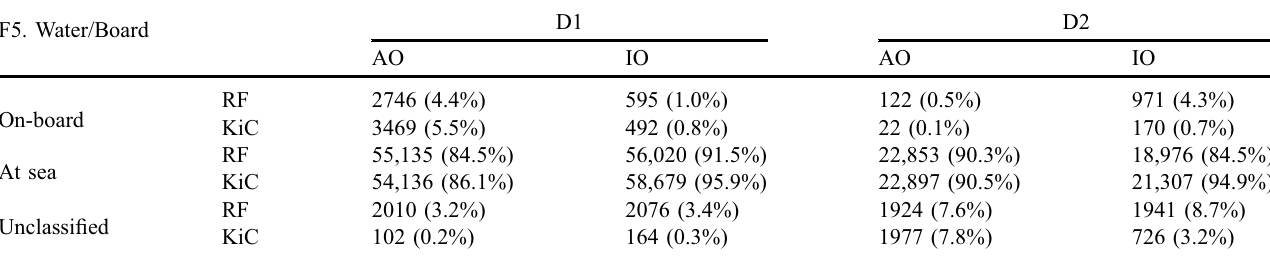
Table 5. Number and percentage (in brackets) of “ at sea ” , “ on-board ” and unclassi fi ed positions from kinetic classi fi cation (KiC) and random forest (RF) algorithm in the different datasets for Atlantic (AO) and Indian (IO)